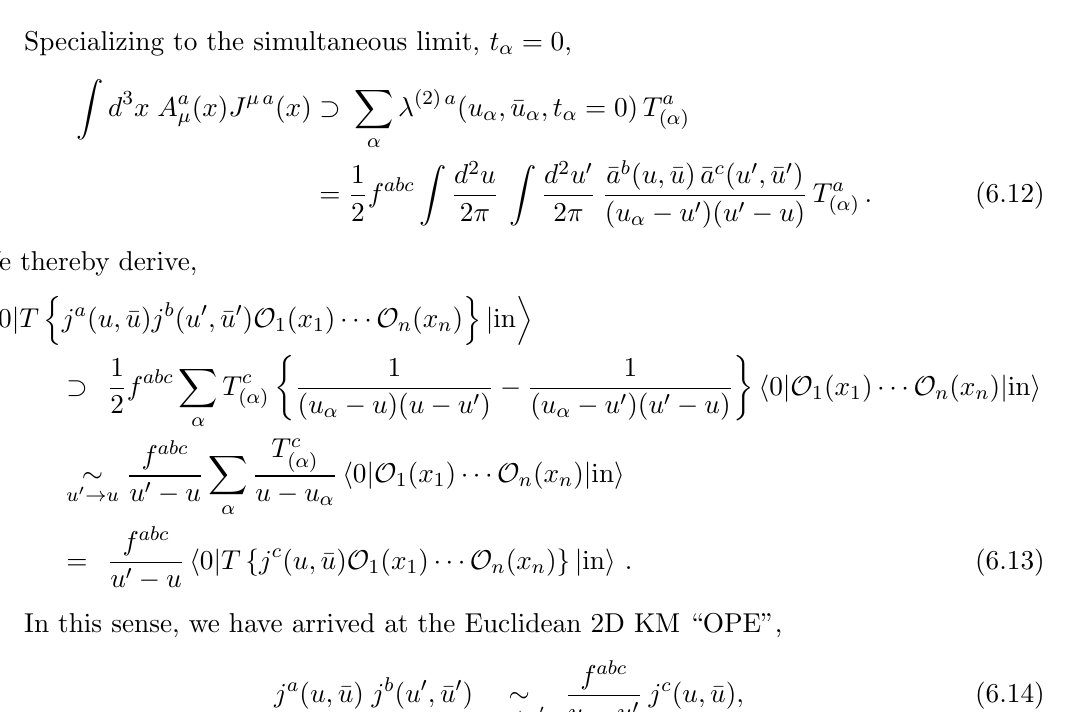
Figure 3. A typical @ AdS 4 correlator for non-abelian AdS gauge theory, with all hard matter arriving at t = 0. Note that there are both non-abelian bulk interactions and non-abelian corrections to the \softened" source in terms of the independent variables (cid:22) a a . The leading source term A (1) is similar in form to the abelian case, while the next non-abelian correction A (2) is given by the last two terms in eq.